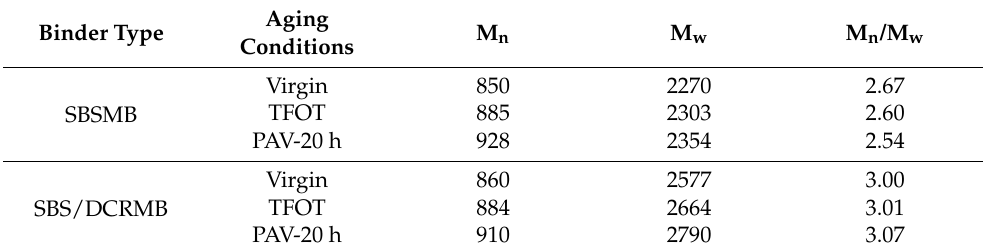
Table 2. Molecular weight calculation of SBSMB and SBS/DCRMB before and after